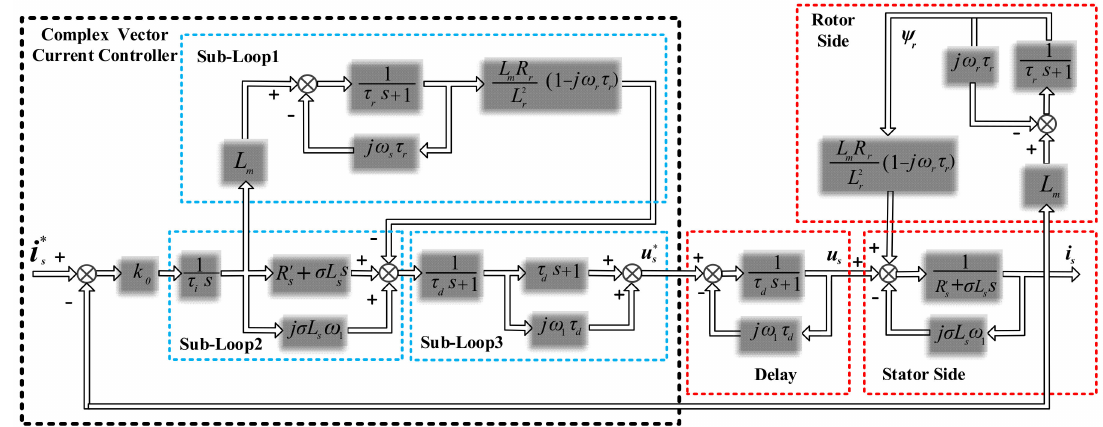
Figure 11. Complex vector current controller-based accurate motor model block diagram.